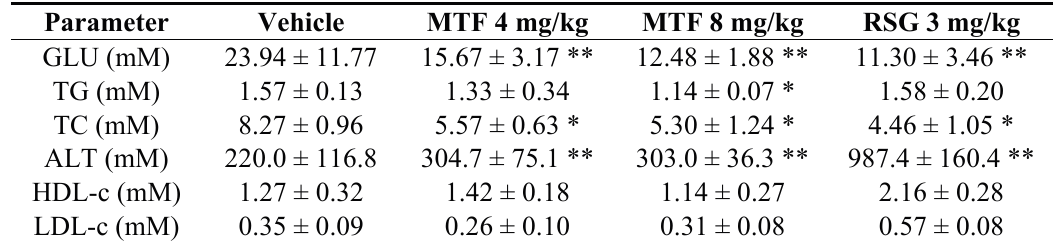
Table 2. Serum parameters of ob/ob